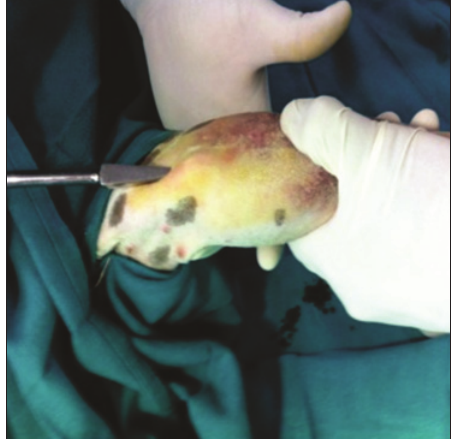
Figure-3: Creation of entry point of the pin for closed pinning using an awl.